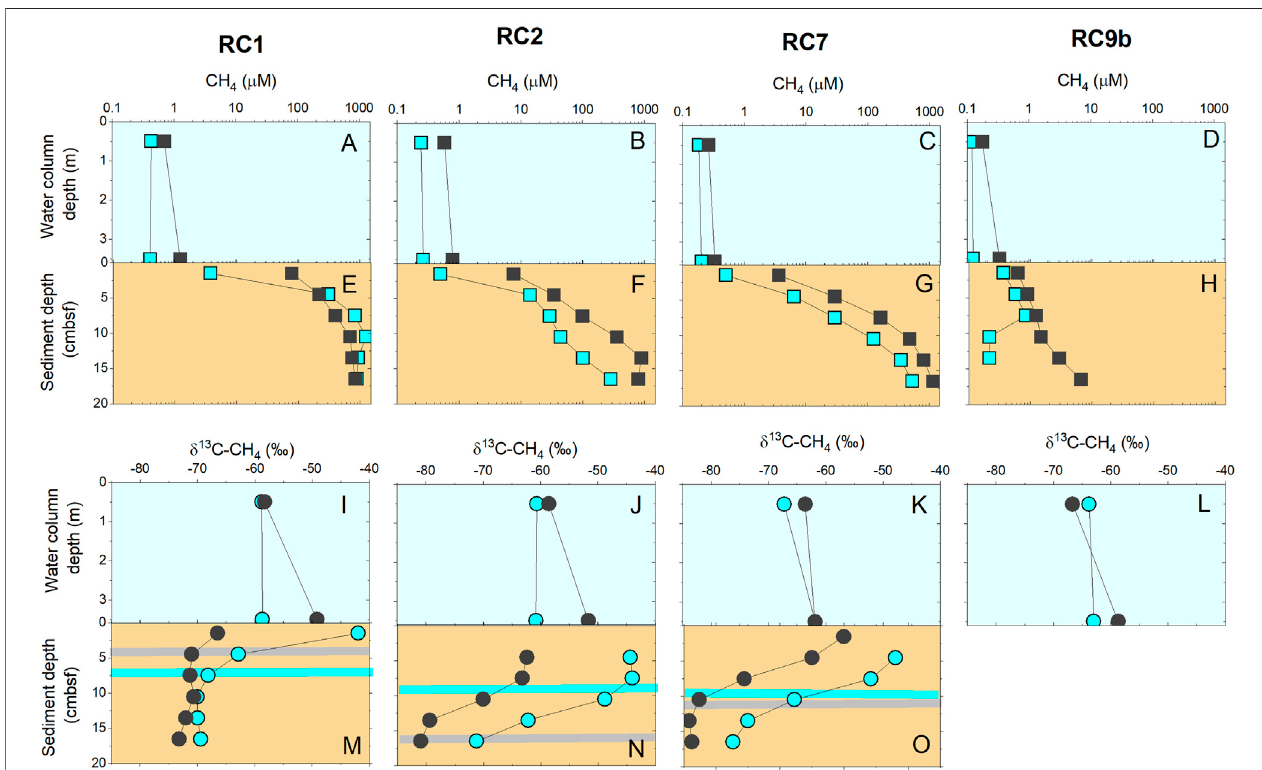
FIGURE 6 | In 2019, methane concentrations (A – H) and stable carbon isotopes (I – O) in water column (blue background) and in sediments (brown background). Blue symbol color denotes when aerators were on, and dark gray when they were off for 13 days. Horizontal bars in sediments (M – O) shows the movement of the sulfate-methane transition zone between ON (blue color) and OFF (gray